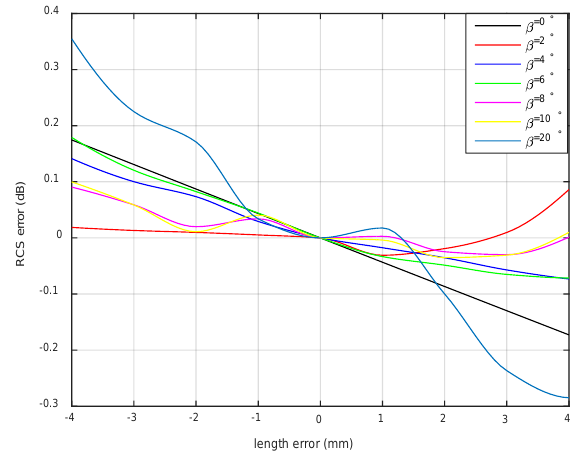
Figure 10. The effect of machining error of length on the RCS at different bistatic angles.